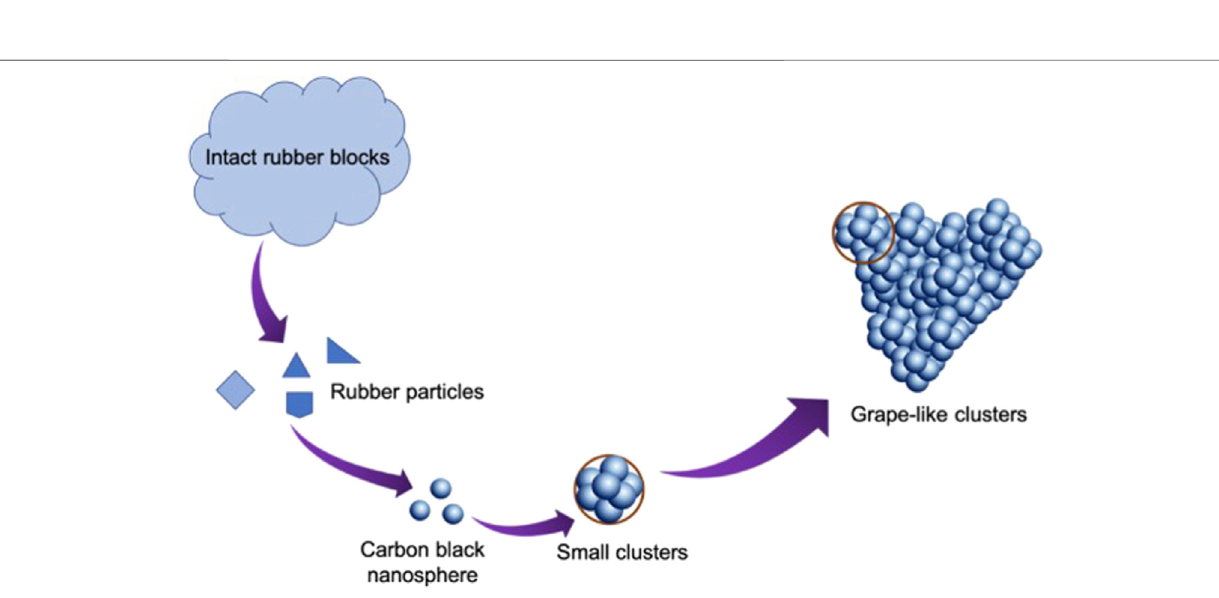
Frontiers in Energy Research |